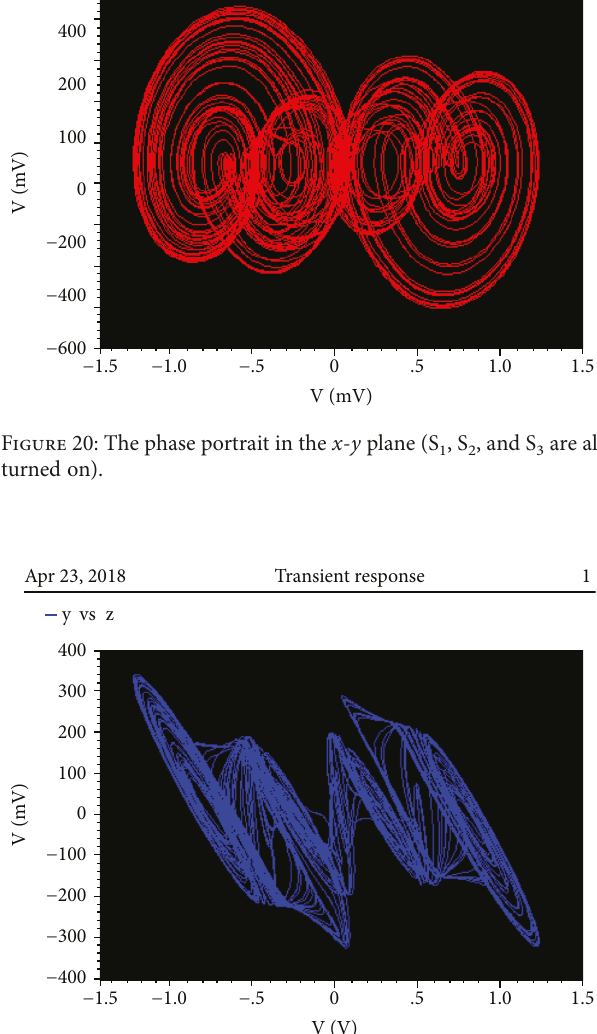
, S , and S are all 1 2 3